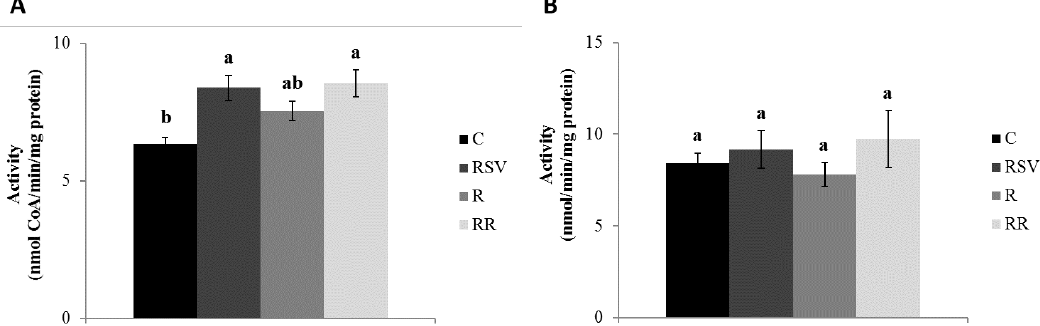
Figure 2. Activities of CPT-1b ( A ) and CS ( B ) in gastrocnemius muscle of rats fed an obesogenic diet for 6 weeks and then shifted to a standard diet (C), or standard diet supplemented with resveratrol (RSV), or submitted to energy restriction and fed a standard diet (R), or submitted to energy restriction and fed a standard diet supplemented with resveratrol (RR) ( n = 9/group) for additional 6 weeks. Values are represented as means ± SEM. Differences among groups were determined by using